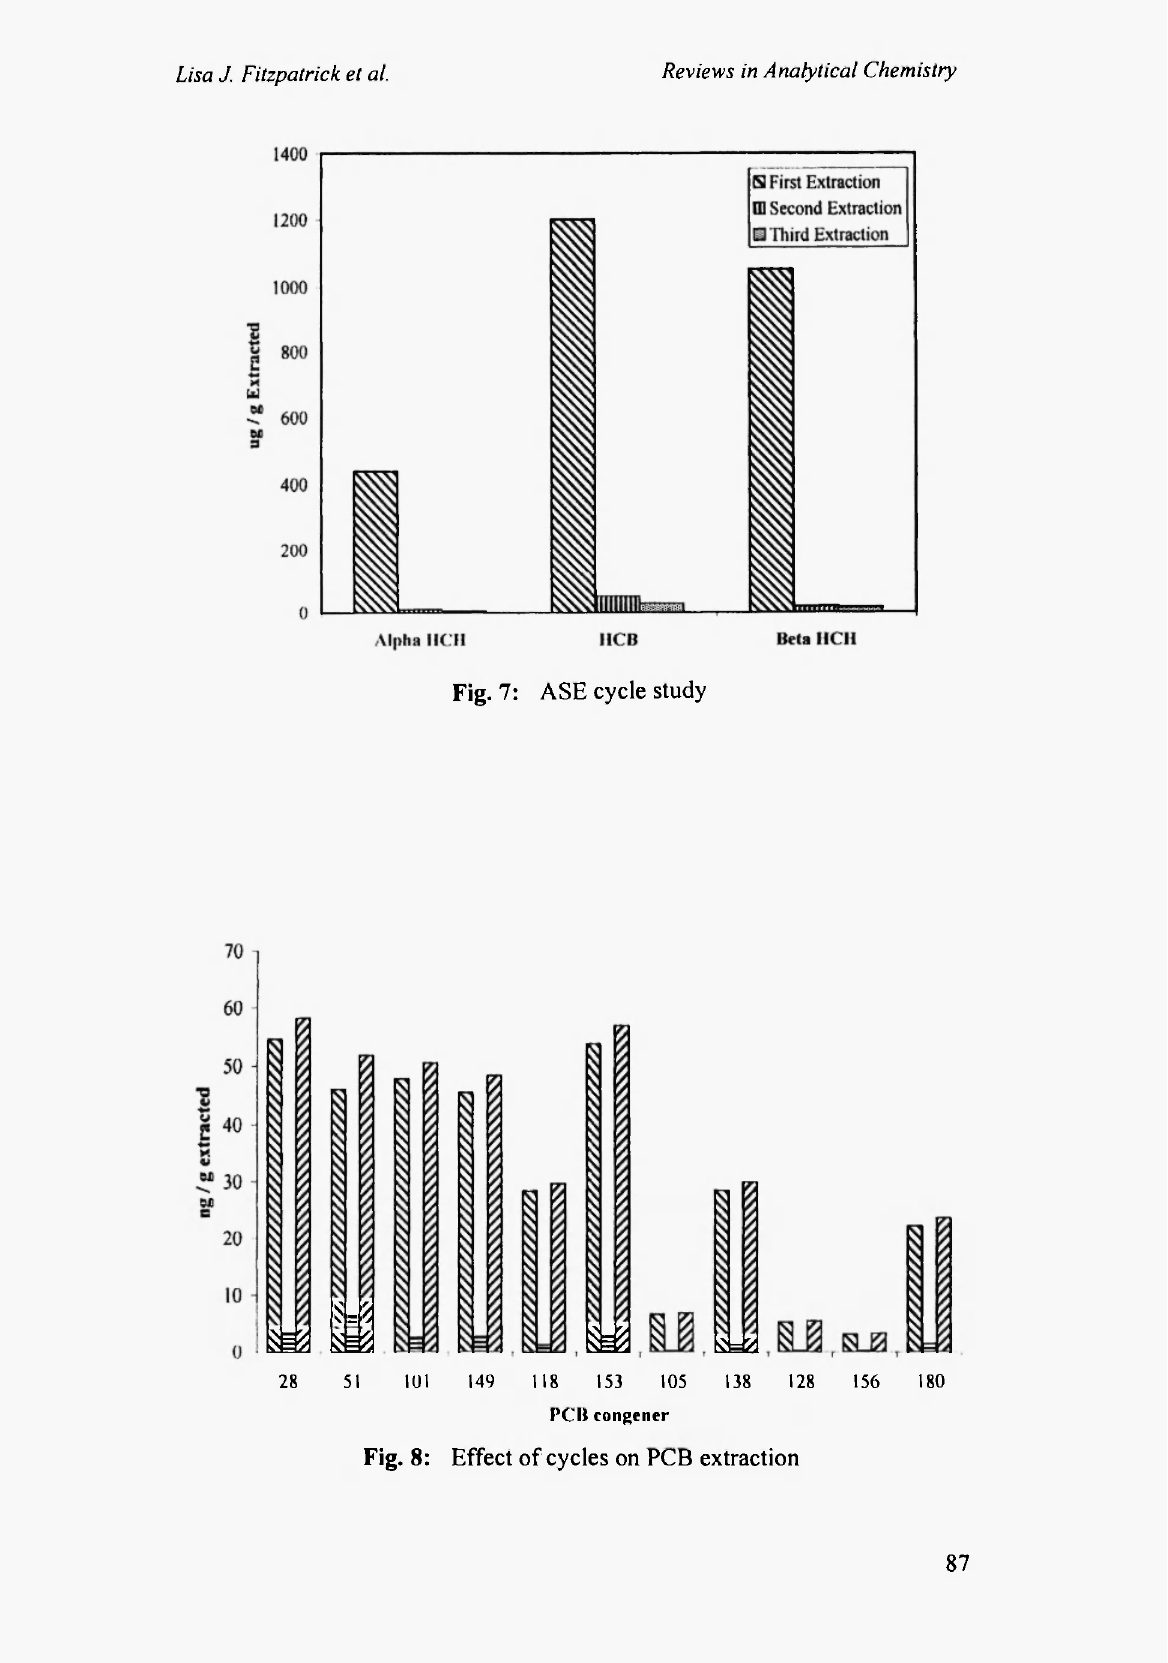
153 105 PCB congener Effect of cycles on PCB